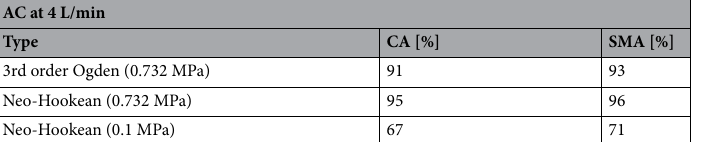
Table 5. Normalized area of the true lumen at the CA and SMA levels of AC and AFC for stiffness in the FSI simulation. AC axillary cannulation, CA celiac artery, SMA superior mesenteric artery.